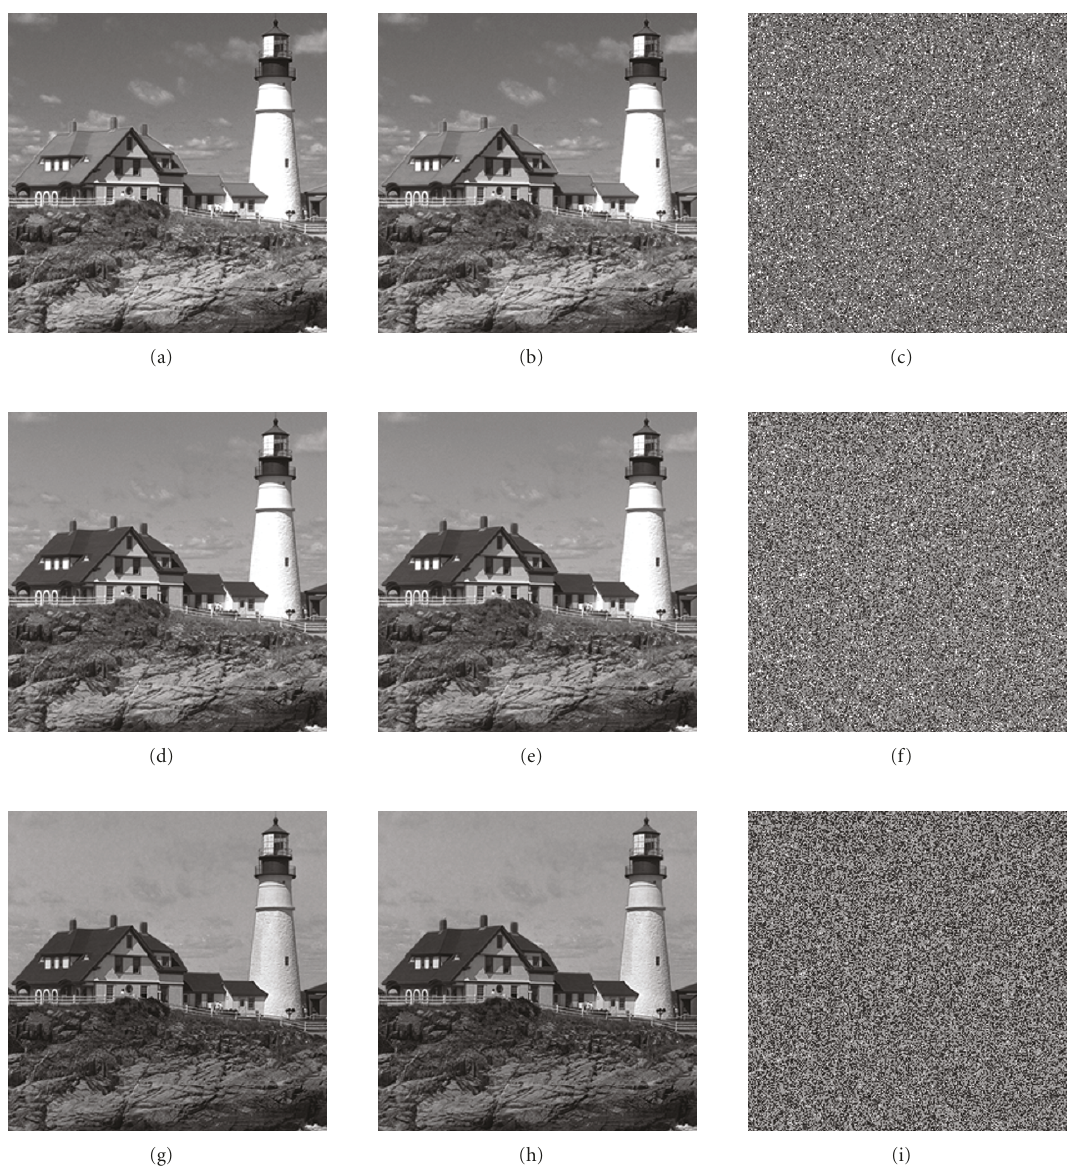
Figure 5: Color components of the Lighthouse image: original components (a),(d),(g), decrypted-watermarked components (b),(e),(h), and encrypted-watermarked components